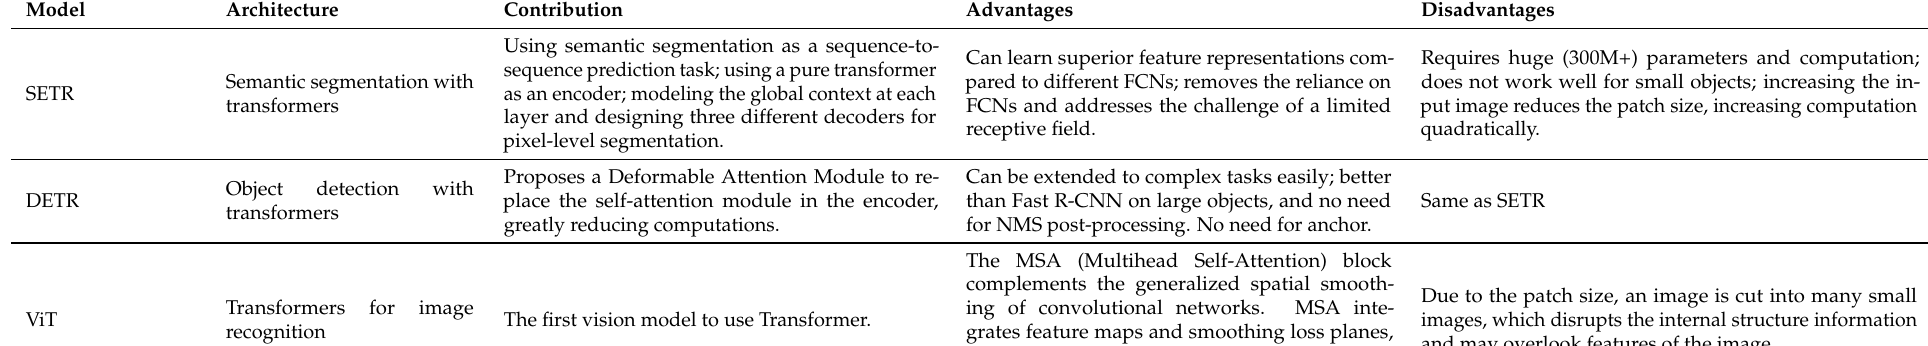
Table 1. Comparison of our proposed model with previous